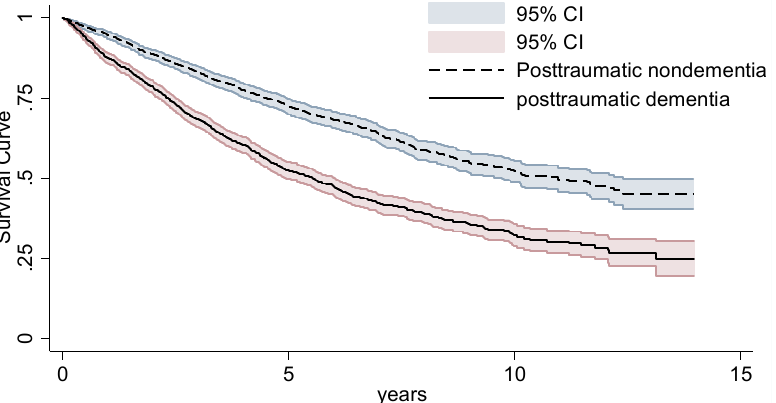
Figure 1. Survival curve between posttraumatic patients with and without posttraumatic dementia. Comparison of the overall mortality rates and HRs of the two cohorts revealed that the mean (range) follow-up times were 4.10 (0.03–14.0) and 5.13 (0.03–14.0) years, and the mortality rates (per